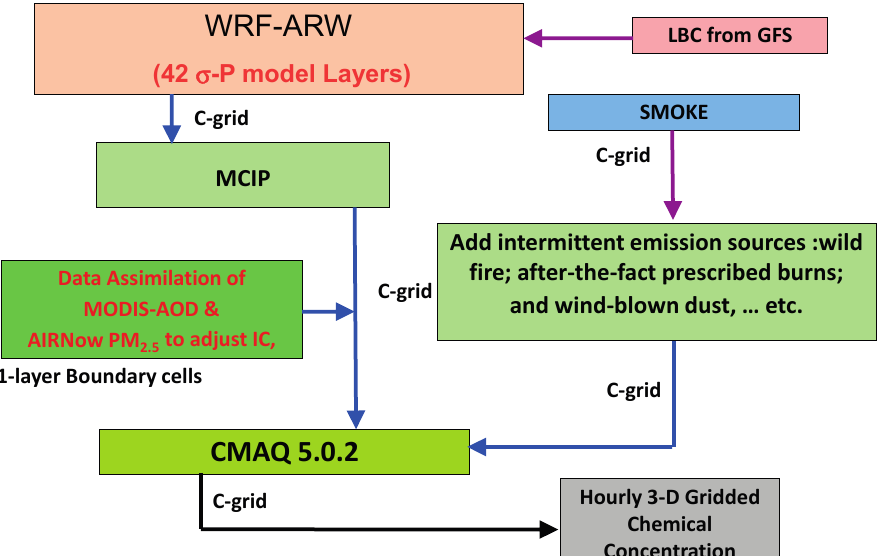
Figure 1. Schematic diagram of the